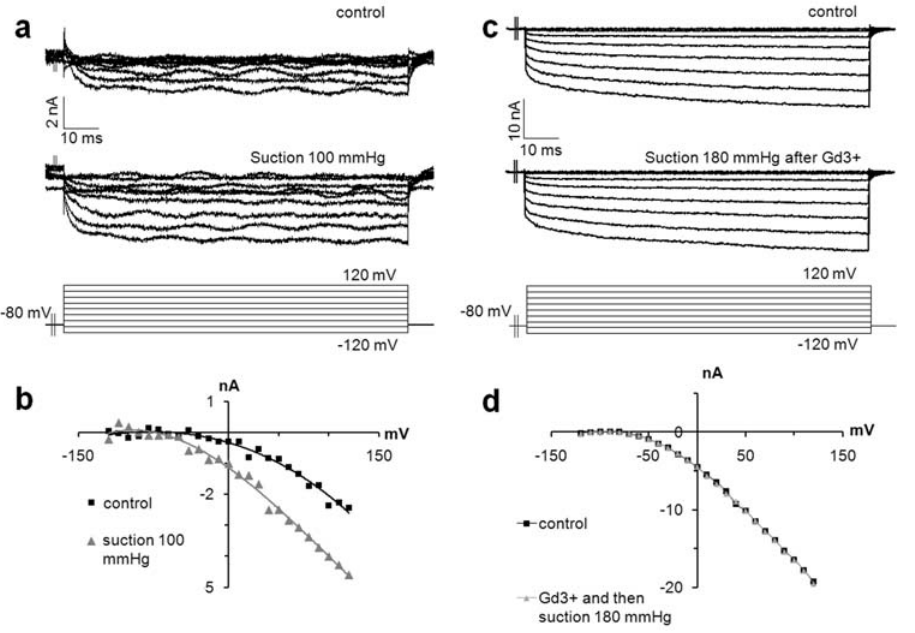
Figure 10. Touch-evoked inward currents are inhibited by Gadolinium. Gd 3 + is a stretch-channel inhibitor. Once added to the medium (100 m M), Gd 3 + inhibited inward currents induced by suction, supporting the presence of stretch channels in MCs. (a) Representative inward Ca 2 + currents recorded in control conditions (top traces) and following the application of suction (bottom traces). (b) Current-voltage relationships demonstrating increased depolarizations during suction (grey triangles) compared to control conditions (black squares). (c) Recorded inward currents in control conditions (top traces) were not modified by suction when cells were pre-exposed to Gd 3 + (bottom traces). (d) Steady-state current densities during the depolarizing step were plotted as a function of membrane potential.